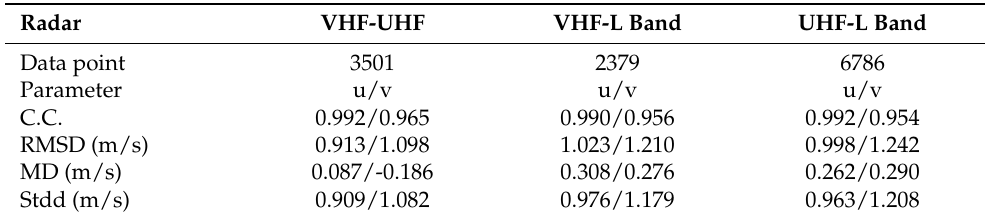
Table 2. Comparisons of zonal wind (u) and meridional wind velocity (v) between wind profilers in the absence of precipitation.